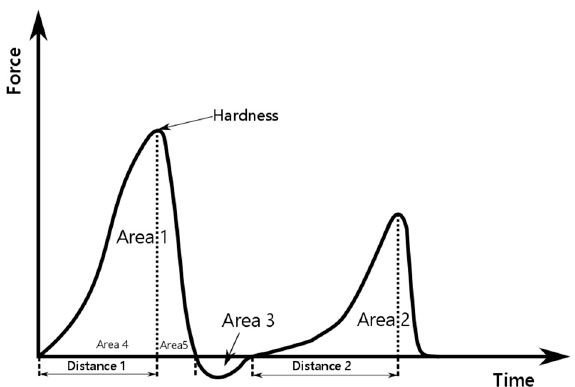
Figure 2. The interpretation of the results from the texture profile analysis test: adhesiveness: Area 3, cohesiveness: Area 2/Area 1, compressibility: Area 1, hardness: maximal force obtained after first deformation